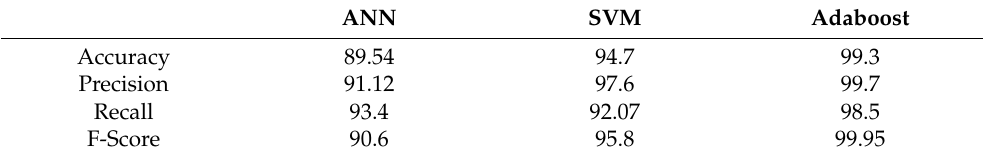
Table 5. Performance (%) of the proposed system using the UNSW-NB15 dataset. ANN SVM Adaboost Accuracy Precision